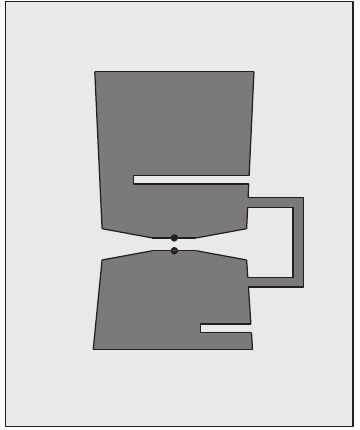
Figure 41: A triple band e-textile antenna [143]. The black dots indicate the feeding points. Dark gray upper conductive polymer fibers (e-fibers) and light gray dielectric textile